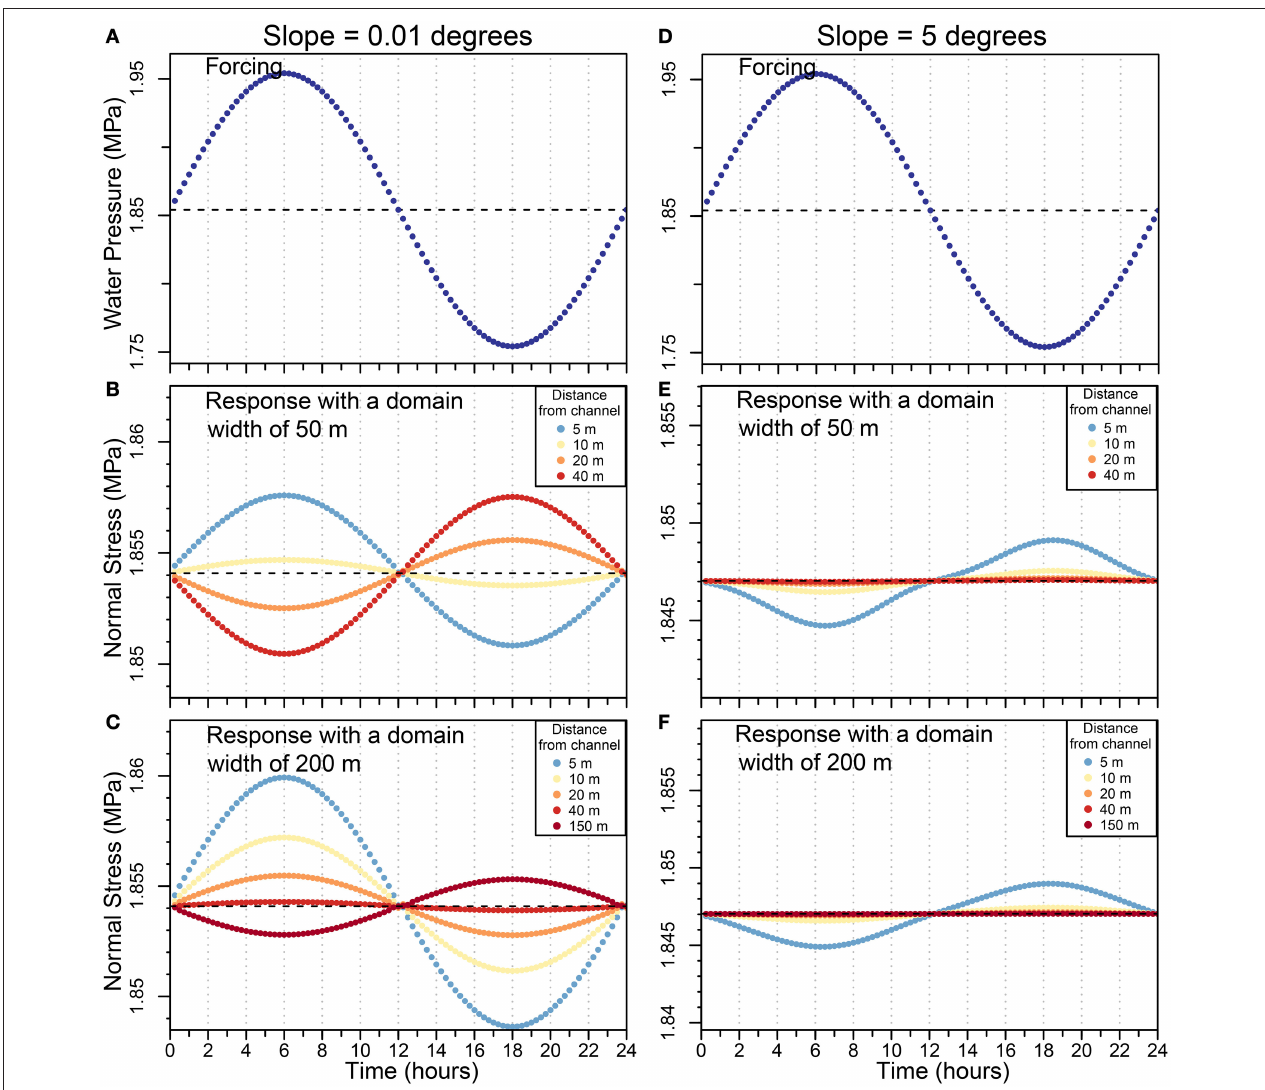
FIGURE 7 | Temporal variation in normal stress at the glacier bed forced by (A–D) a varying water pressure inside a channel of 0.5 m radius for a period of 24 h and for slopes of (B,C) 0.01 degrees and (E,F) 5 degrees as well as two domain widths of (B–E) 50 m and (C–F) 200 m. Normal stresses are calculated at 5, 10, 20, 40, and 150 m from the channel